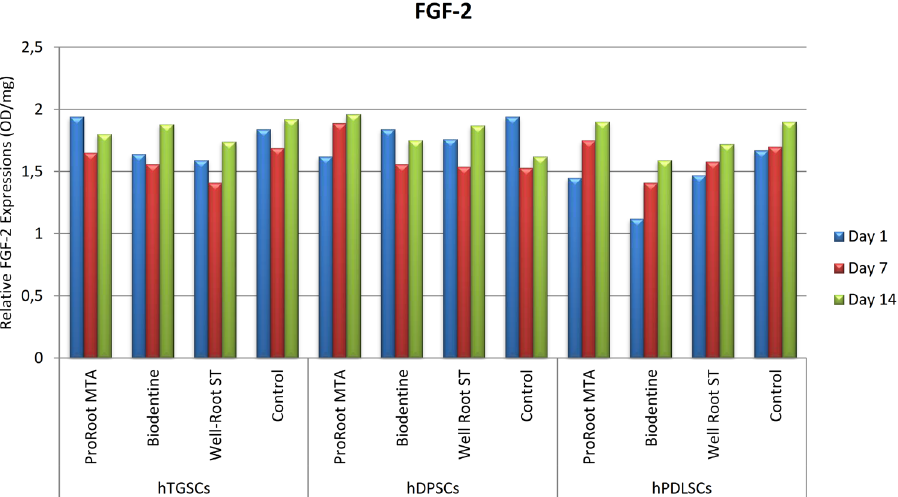
Figure 3- The visualized results of tested materials with ELISA test on different stem cell types for FGF-2. hDPSCs: human dental pulp stem cells; hPLSCs: human periodontal ligament stem cells; hTGSCs: human tooth germ stem cells; FGF-2: basic fibroblast growth